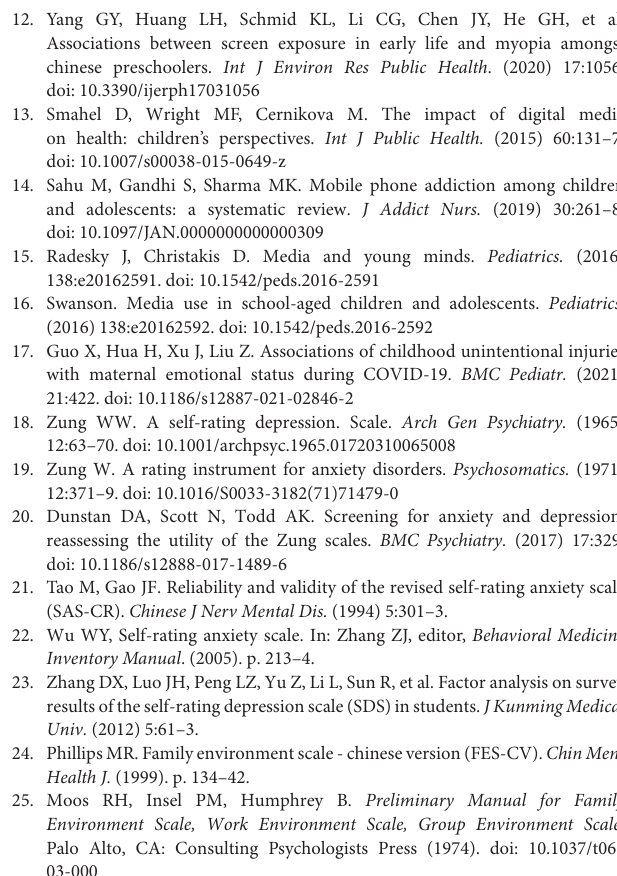
Supplementary Figure 1 | The adjusted relationships between child over-use of electronic devices and family environment [ β (95%CI)]. Adjusting for child age, child gender, maternal age, maternal educational background, family structure, and home residency.